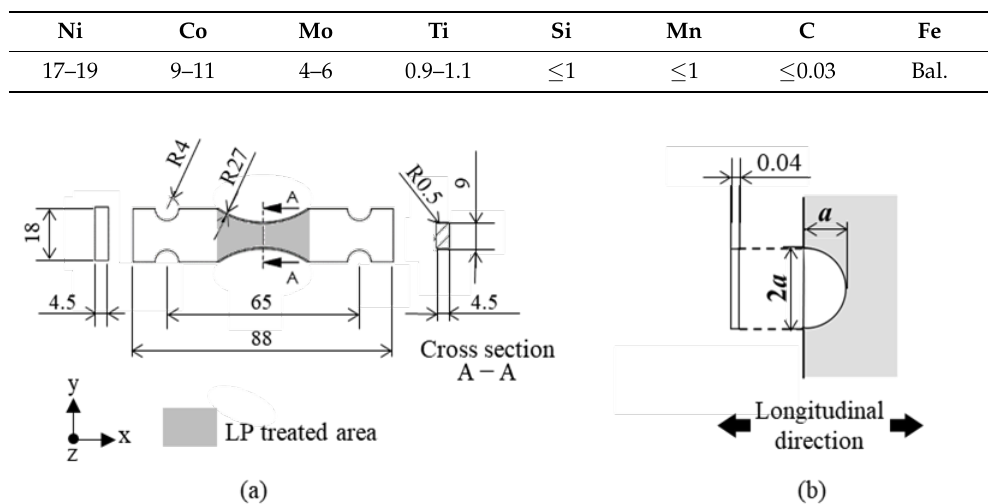
Table 1. Chemical composition of maraging steel (wt%).